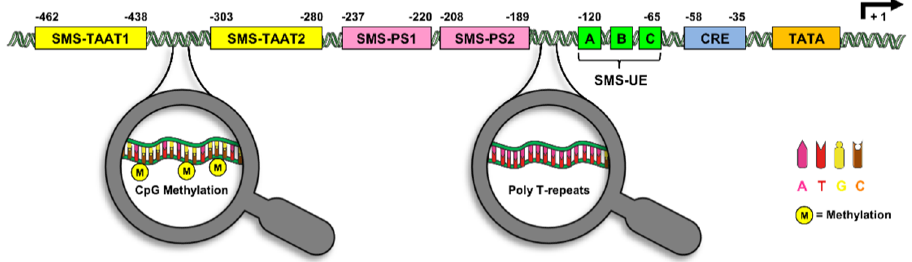
Figure 2. Regulatory elements of the rat somatostatin promoter. The somatostatin promoter harbors a complex arrangement of multiple regulatory elements, such as cAMP response element (CRE), specific upstream-enhancer elements (SMS-UE, SMS-TAAT1, and SMS-TAAT2) interspersed with the proximal silencer elements (SMS-PS1 and SMS-PS2) upstream of the TATA box. Moreover, additional